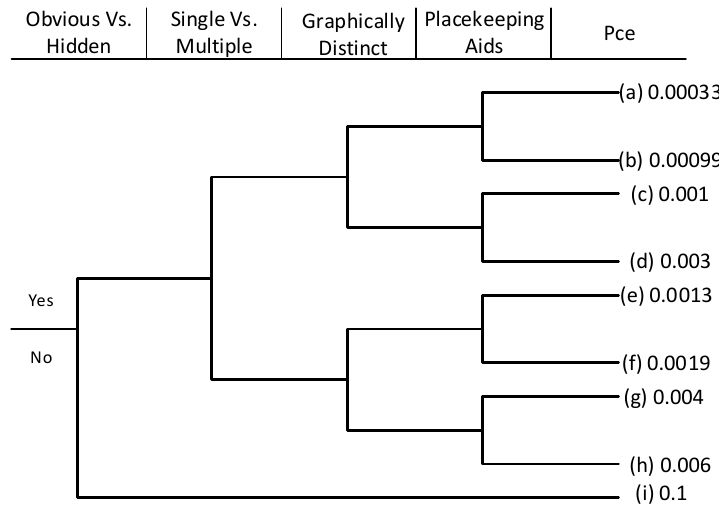
Figure 7. Pce in the MCBDT.